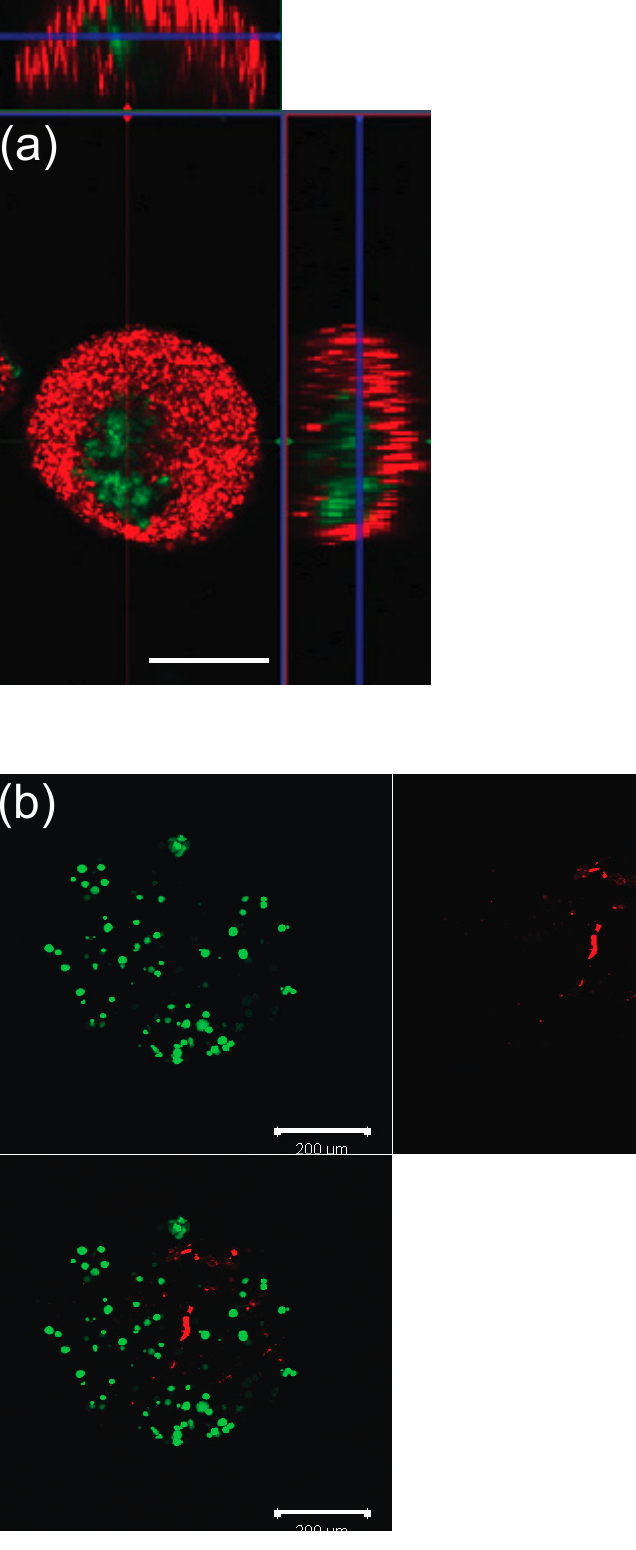
Figure 3. Spatial distribution of capsule (day 0). ( a ) Fluorescent beads ( b ) Granulosa cell and theca cell stained with Cell Tracker to red and green, respectively. Scale bar, 200 μ m.